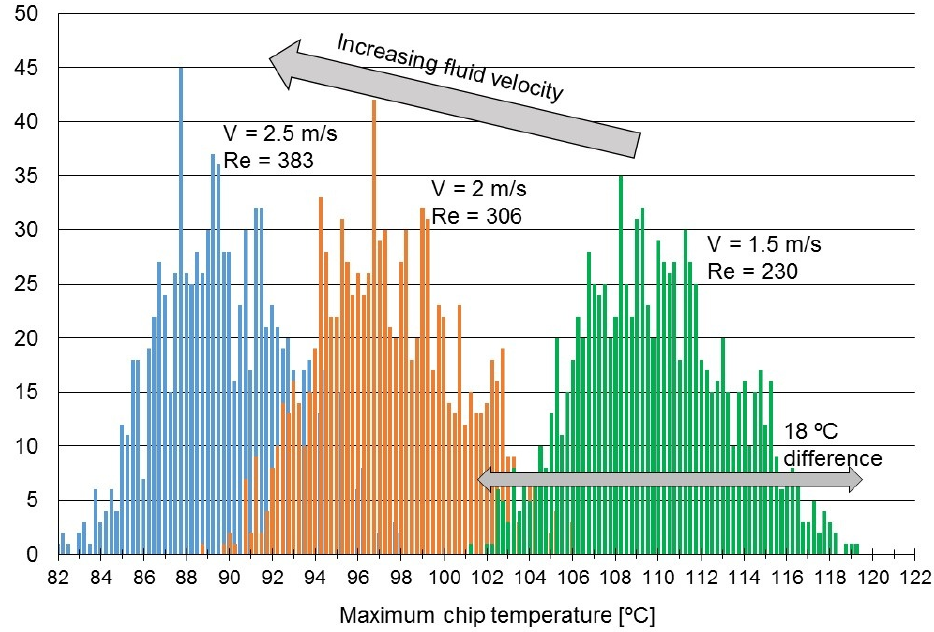
Figure 6. Peak temperature distribution (1000 cases in total) in the simulated 3D processor for various fluid velocities. Power consumption in processor cores was generated randomly once, and only power-to-core mapping was varied between cases. Re indicates the Reynolds number.